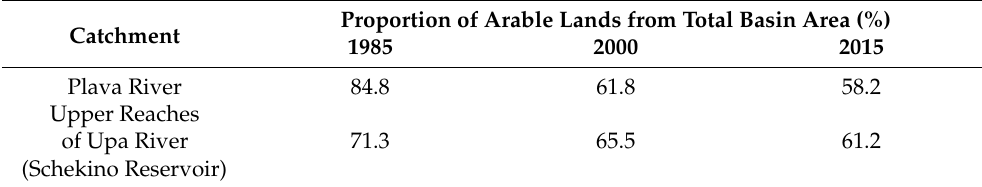
Table 4. Proportions of arable land from total basin area of Plava River and upper reaches of Upa River (catchment area of Schekino Reservoir) in 1985, 2000, and